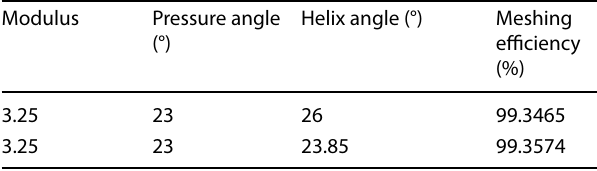
lubrication for meshing power loss in future research, Table 3 Optimization comparison of helix angle parameters more profound work would be taken into account to grad- Modulus Pressure angle Helix angle (°) Meshing ually form a more complete power loss calculation model (°) of herring tooth star gear transmission system.